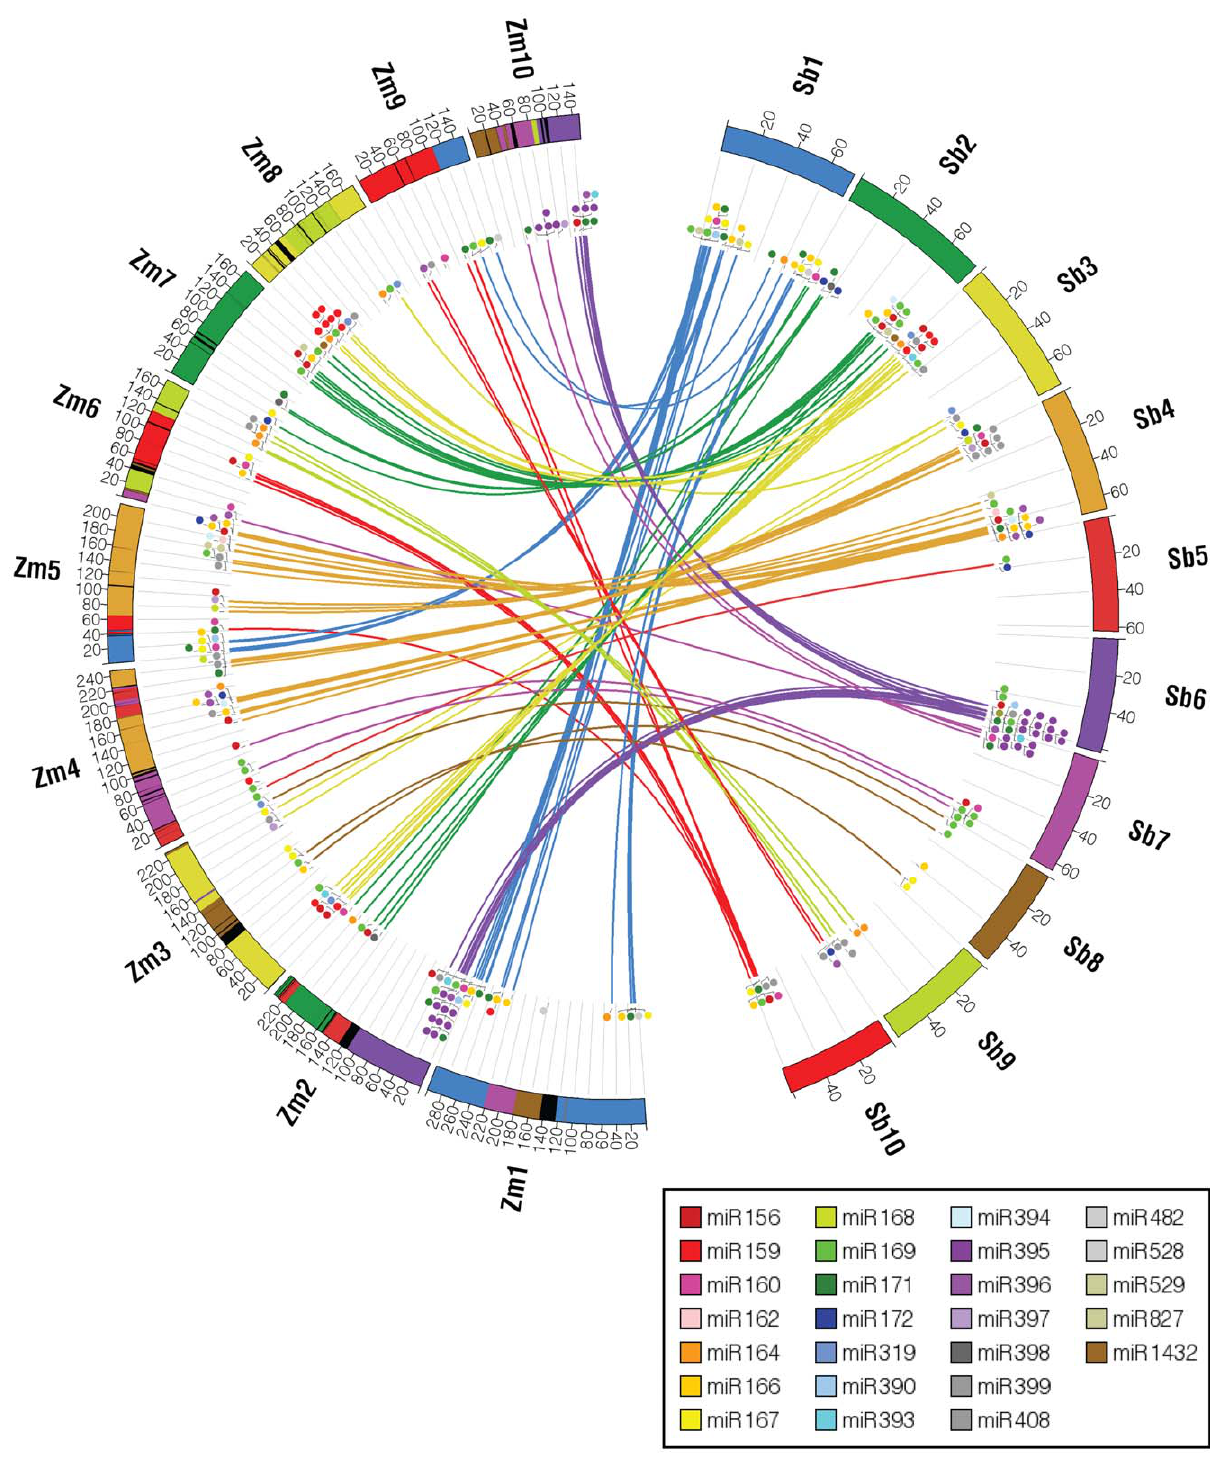
Figure 6. Comparative map between maize and sorghum genomes showing links between syntenic MIR genes. Positions of annotated MIR genes are shown using circles that are color-coded according to the family. Links show synteny between MIR genes. Maize and Sorghum chromosomes are color-coded such that syntenic regions, based on protein coding genes, have matching colors. doi:10.1371/journal.pgen.1000716.g006 predictions. This high confidence set represents genuine miRNA and identification of orthologous genes in sorghum (see further genes is reinforced by our characterization of pre-miRNA discussion below). Plant miRNA families can be historically structures, promoter features, expression profiles, genetic diversity, divided into two classes: the highly conserved families, and the